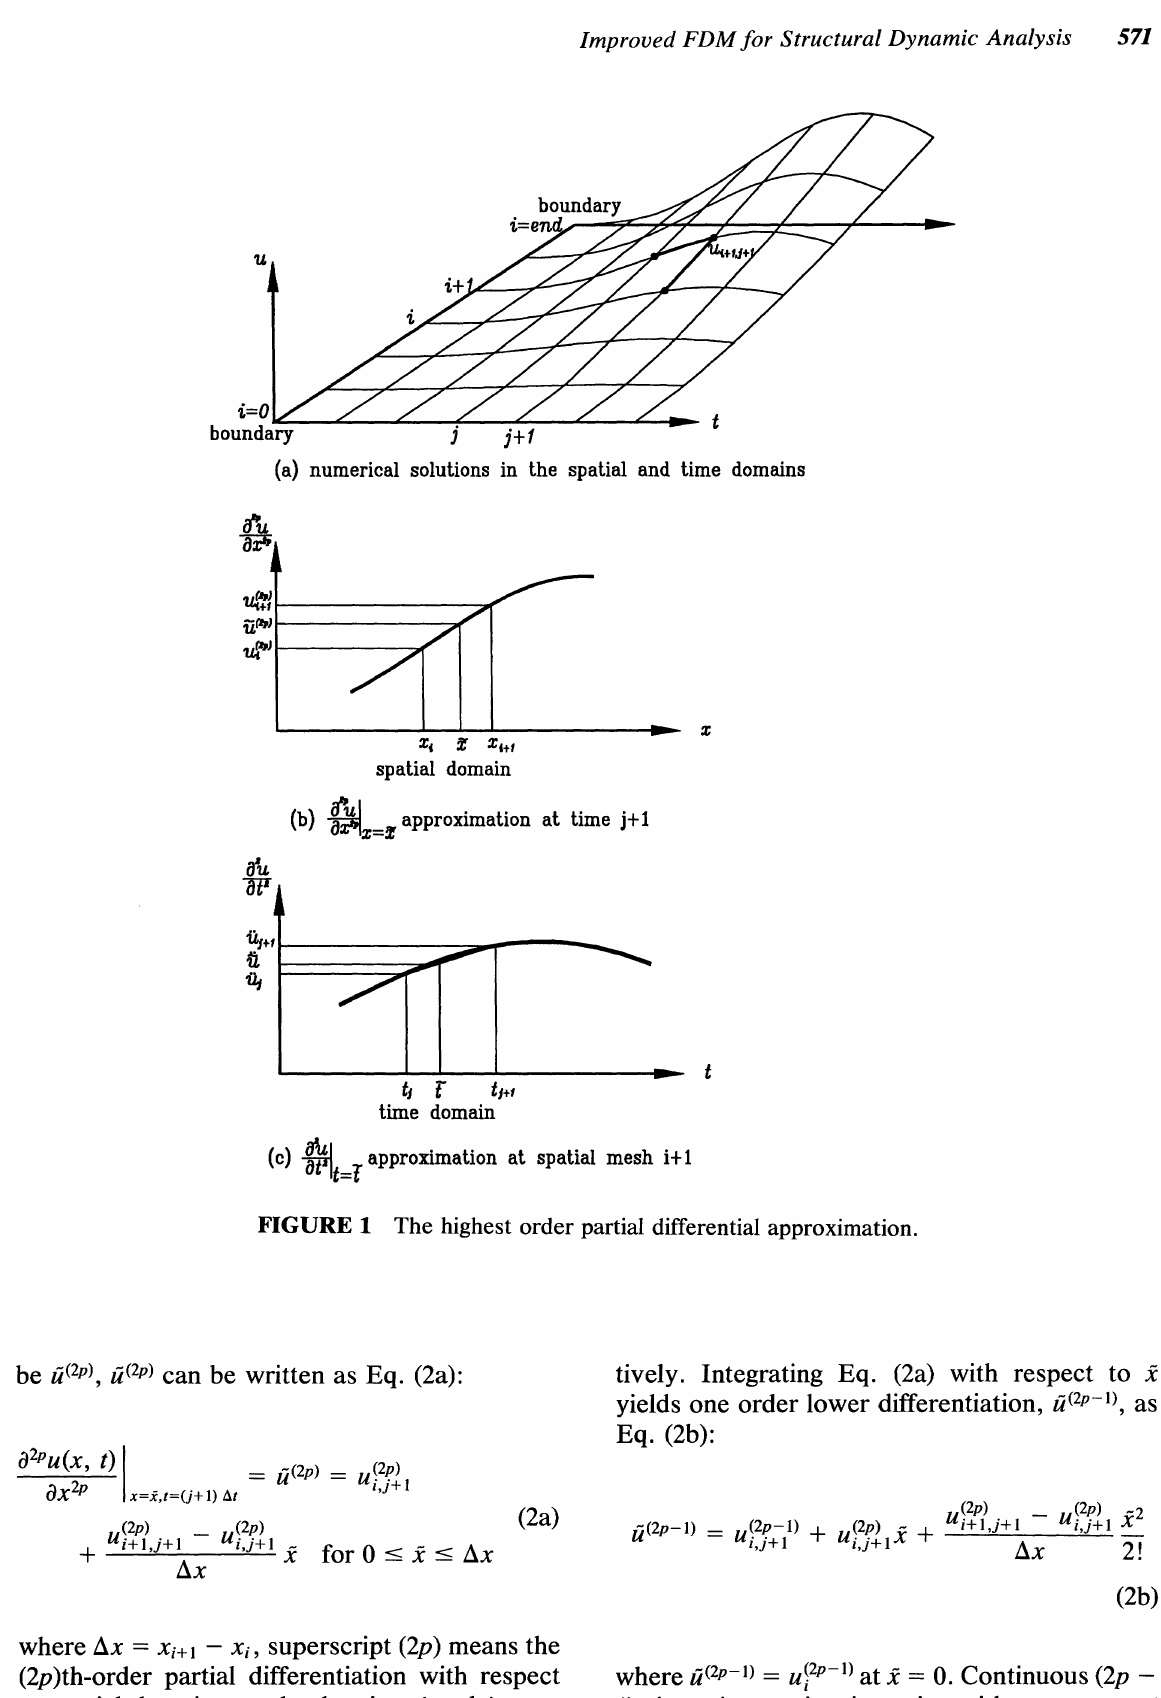
FIGURE 1 The highest order partial differential